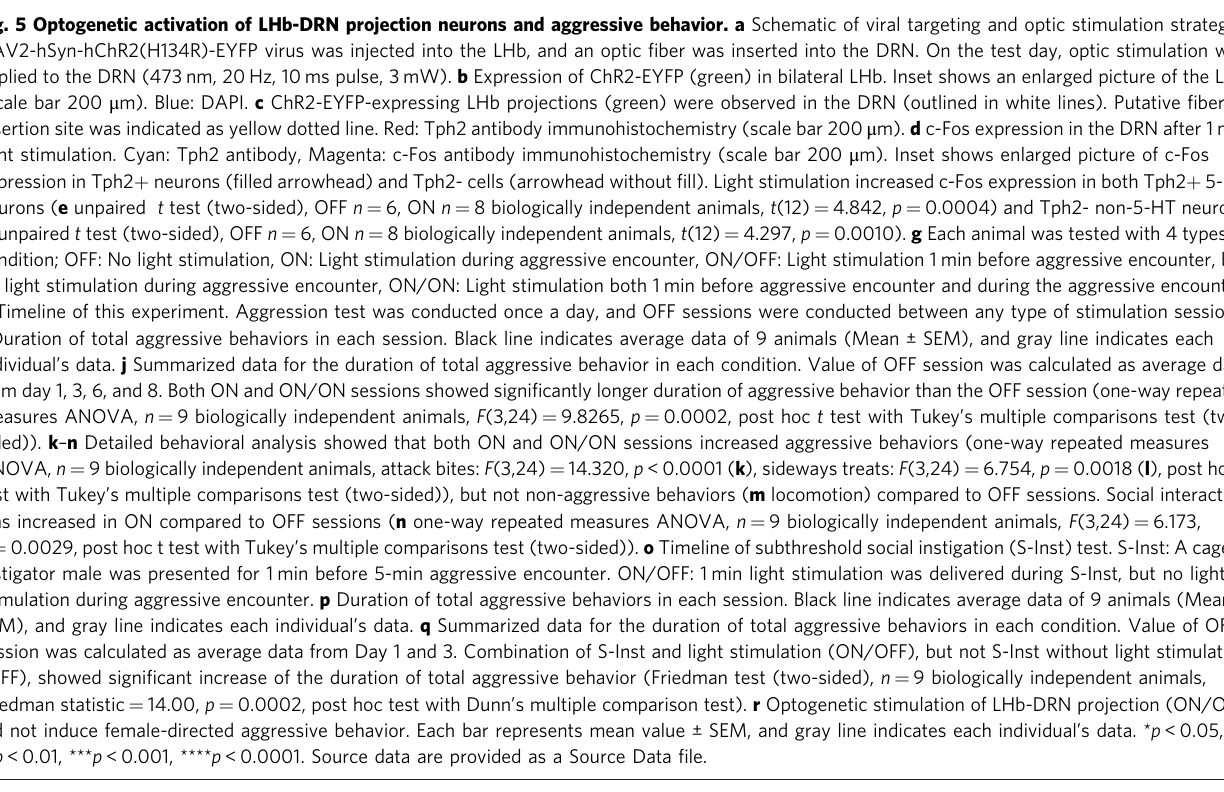
Fig. 5 Optogenetic activation of LHb-DRN projection neurons and aggressive behavior. a Schematic of viral targeting and optic stimulation strategy. AAV2-hSyn-hChR2(H134R)-EYFP virus was injected into the LHb, and an optic fi ber was inserted into the DRN. On the test day, optic stimulation was applied to the DRN (473 nm, 20 Hz, 10 ms pulse, 3 mW). b Expression of ChR2-EYFP (green) in bilateral LHb. Inset shows an enlarged picture of the